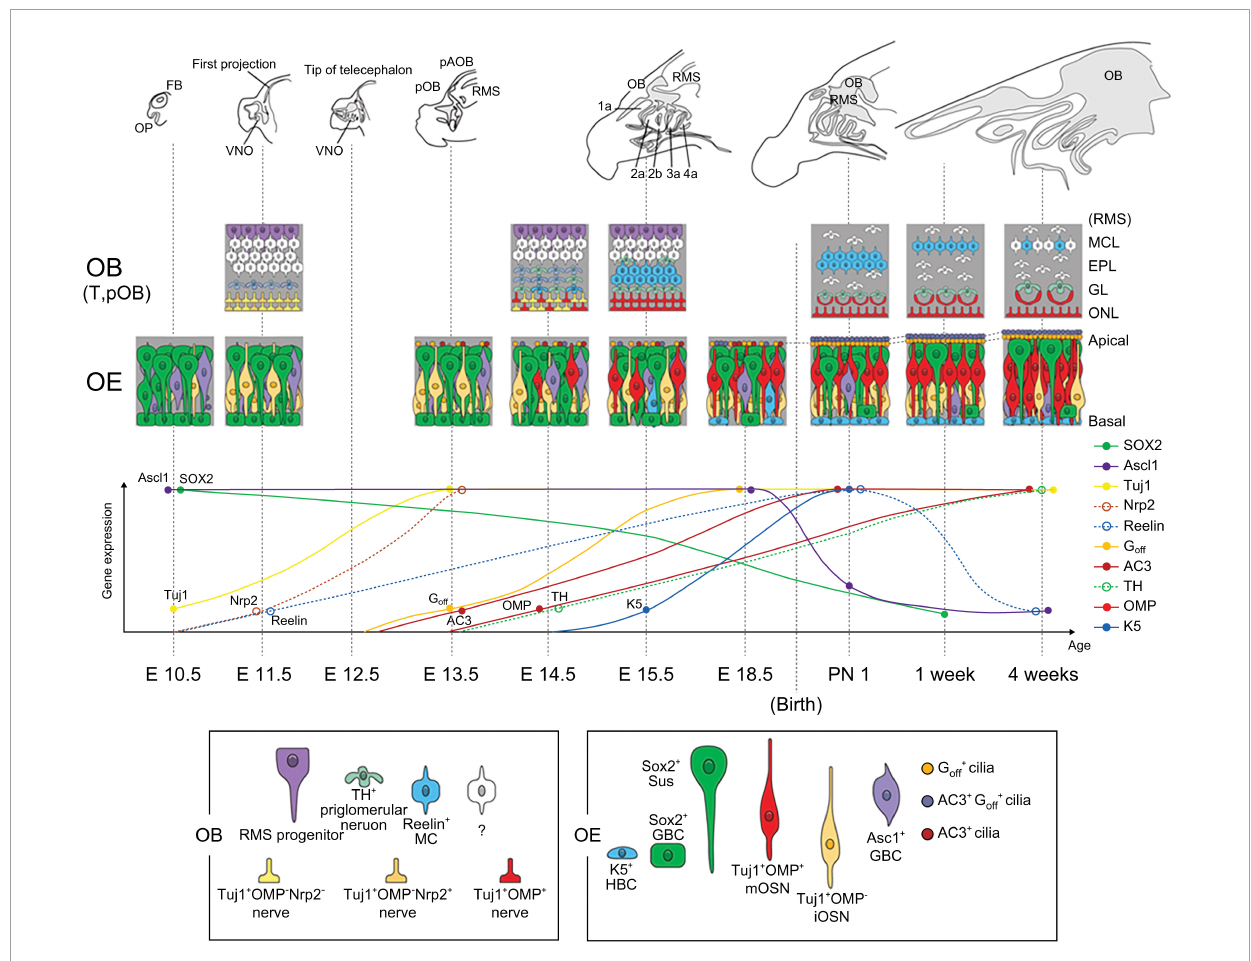
FIGURE6 Schematic diagram of the developmental changes in olfactory system. The scheme presents the serial changes in morphology, cell composition, and gene expression with